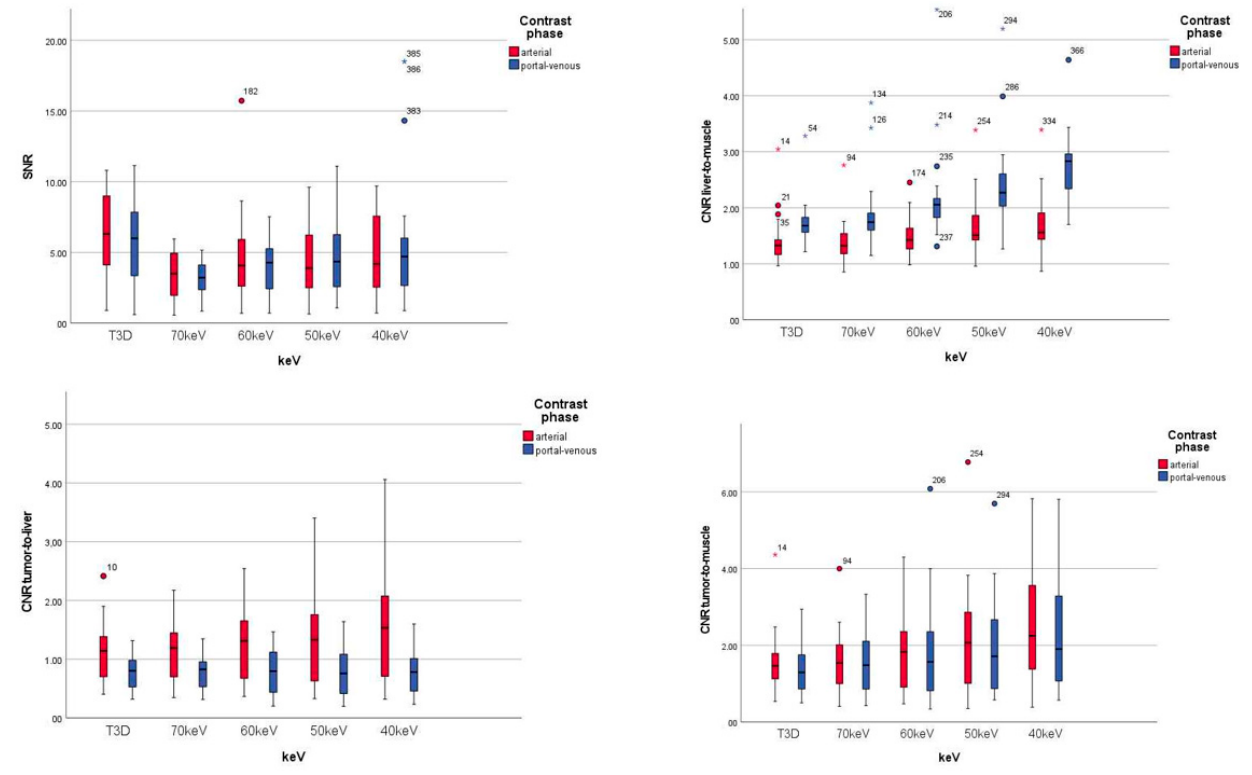
Figure 2. Comparison of different keV levels in terms of SNR and CNR. Table 4. Comparison of SNR of arterial and portal venous phases.